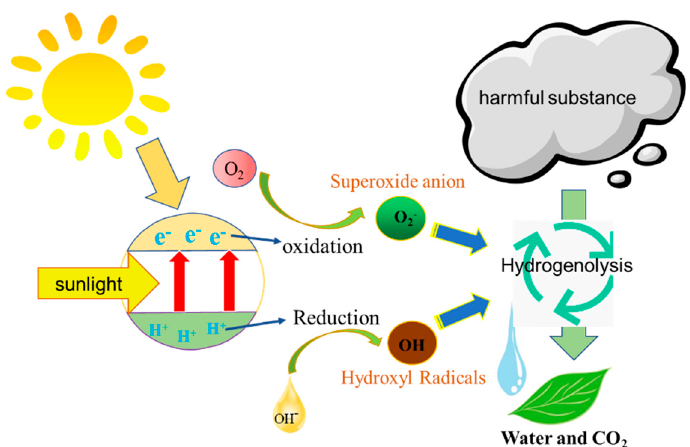
Figure 6. Photocatalytic reaction mechanism diagram.